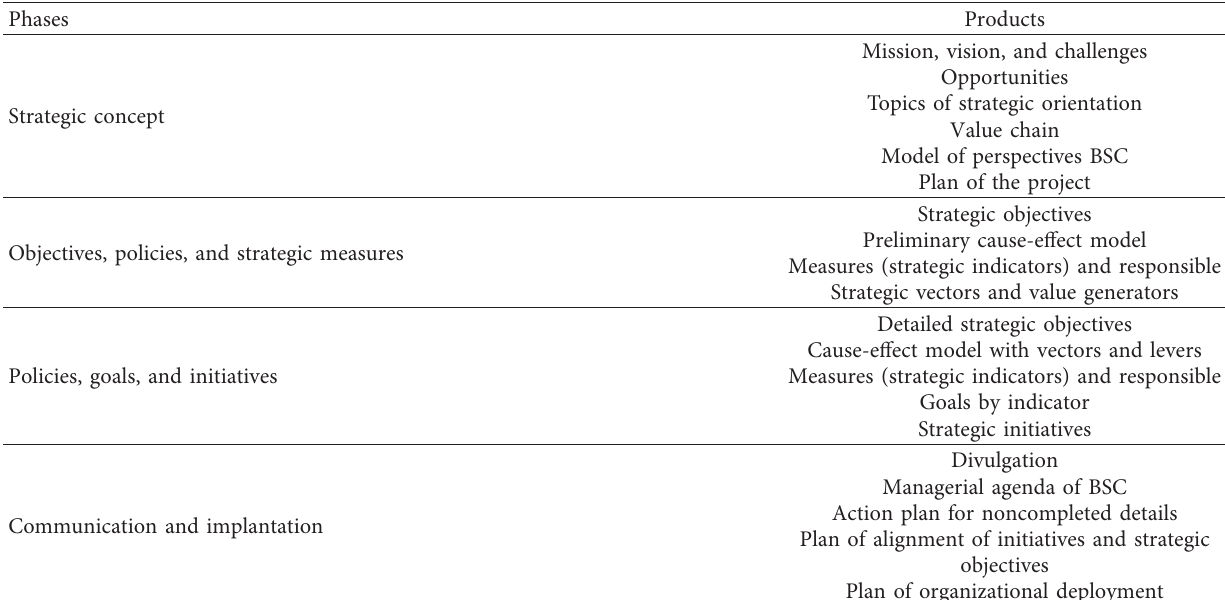
Table 9: Phase of the BSC